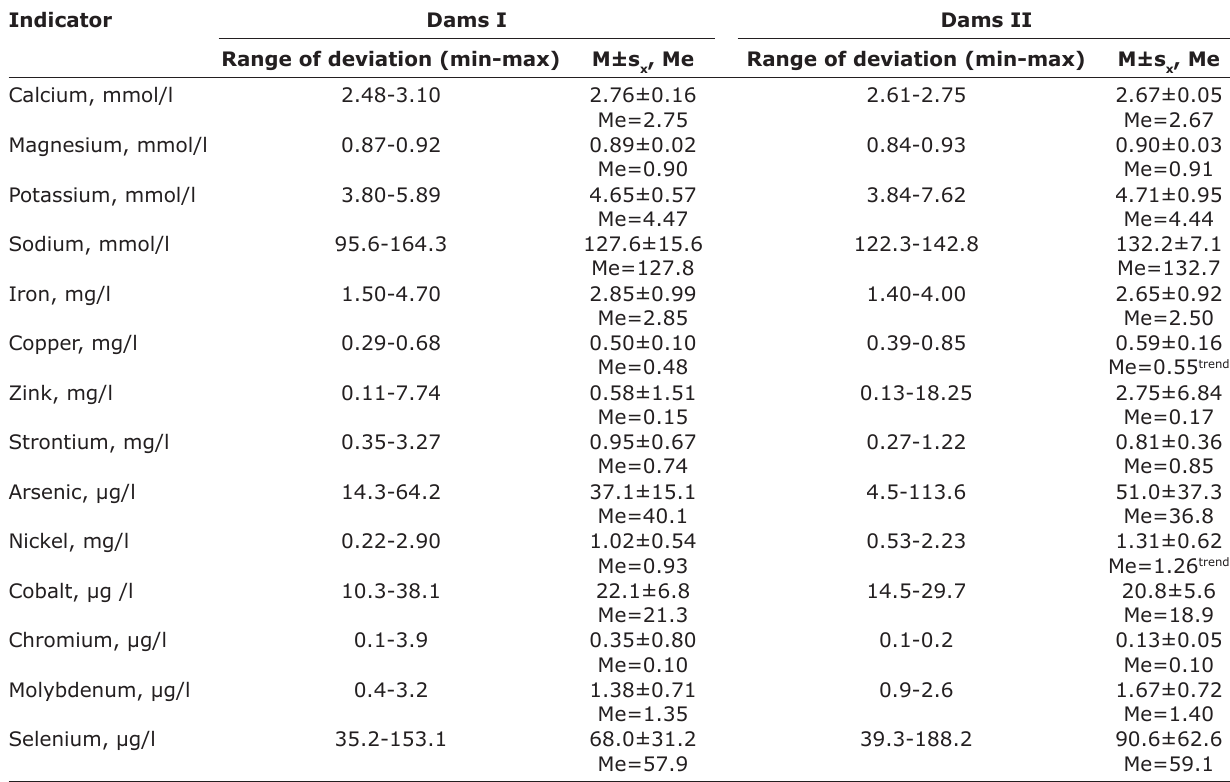
Table-1: Macroelements and microelements content in blood serum of the down-calving cows.